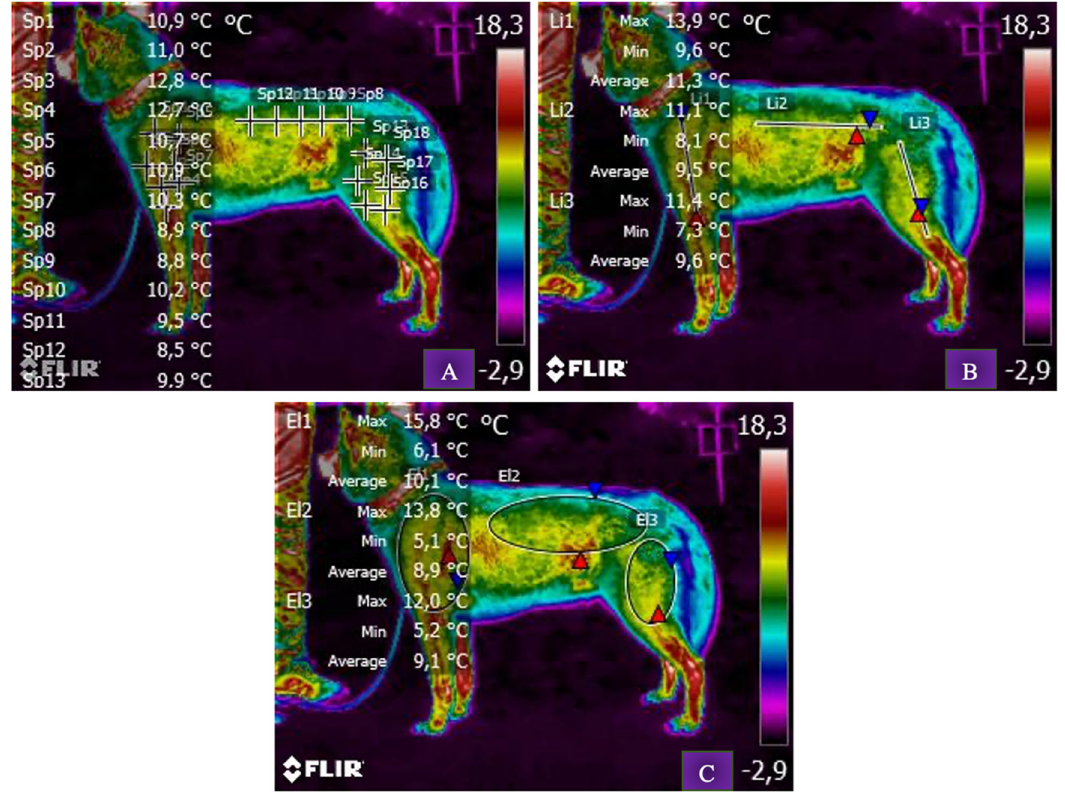
Figure 2. Five-and-a-half-year-old, female, Siberian Husky dog. Pattern of measurement of left homobrachial region (OSX), thoraco-lumbar region and left dorsal portion of the ventro-lateral region of the abdomen (LSX) and left thigh region (CSX). For each ROI, the body surface temperature was measured using three techniques: by points of interest ( A ), by lines ( B ) and by areas ( C ). The brighter colors (red, orange, and yellow) indicate warmer temperatures (more heat and infrared radiation emitted), while the purples and dark blue/black indicate cooler temperatures (less heat and infrared radiation emitted). Moreover, all commas inserted in the measurements within the figure are indi- cated according to the Italian style, therefore they must be understood as points to indicate decimals following the British style. Sp = Spot. Li = Line. El = elliptical area. All data were submitted to descriptive (mean ± standard deviation-SD and median) and analytic statistical analysis. A paired T-test was applied to investigate differences between the pre- and post-race temperature in the different ROIs. Dogs were also divided into two groups according to the distance of the race (mid-distance (30 km) and sprint ( ≤ 16 km) and the Mann–Whitney U test was used to compare the difference in ocular temperatures at the end of the race (T1). The significance level was set for a p value ≤ 0.05. All data were analysed using Stata version 16 software (StataCorp, College Station, TX, USA-2019). 3. Results In total, 66 ocular thermographic images and 429 superficial body images were ana- lysed. The environmental temperature ranged from − 5 °C to +3 °C and from 8 °C to 10 °C when data at T0 and T1 were collected, respectively. Considering the entire group of dogs, in the pre-competition phase (T0) the mean temperature of the right eye was 32.98 ± 1.68 °C, while in the left eye the mean value was 32.83 ± 1.57 °C; in the post-race (T1) the mean temperature was 35.08 ± 0.95 °C and 34.95 ± 0.88 °C for the right and left eye, respectively (Table 2 and Figure 3).